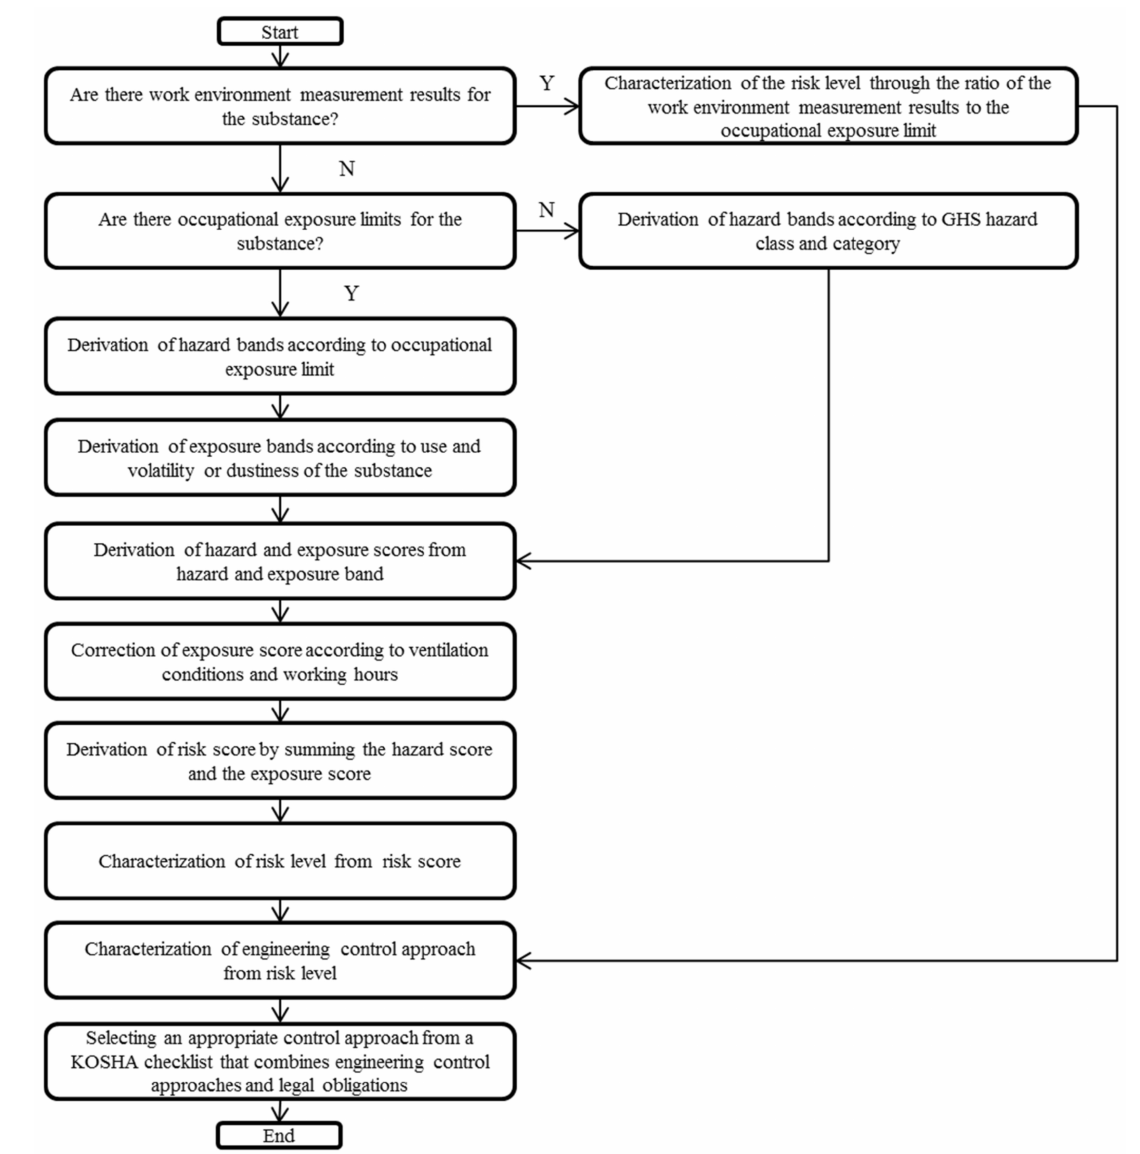
Figure 1. Flowchart of the risk assessment method. Table 1. Definition of risk levels derived from the ratio of the work environment monitoring results to the occupational exposure limit